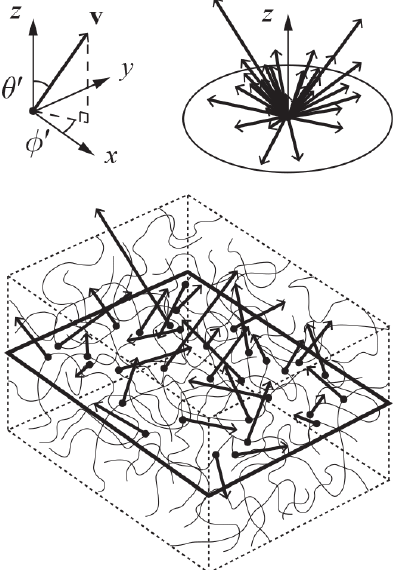
Figure B1. Velocities v of different vein segments crossing a plane (outlined by bold rectangle) and their distribution in spherical coor- dinates (upper right). Only crossings in one direction are shown. In Appendix B, a statistical theory is used to calculate the net transport of porosity and vein impurity resulting from this